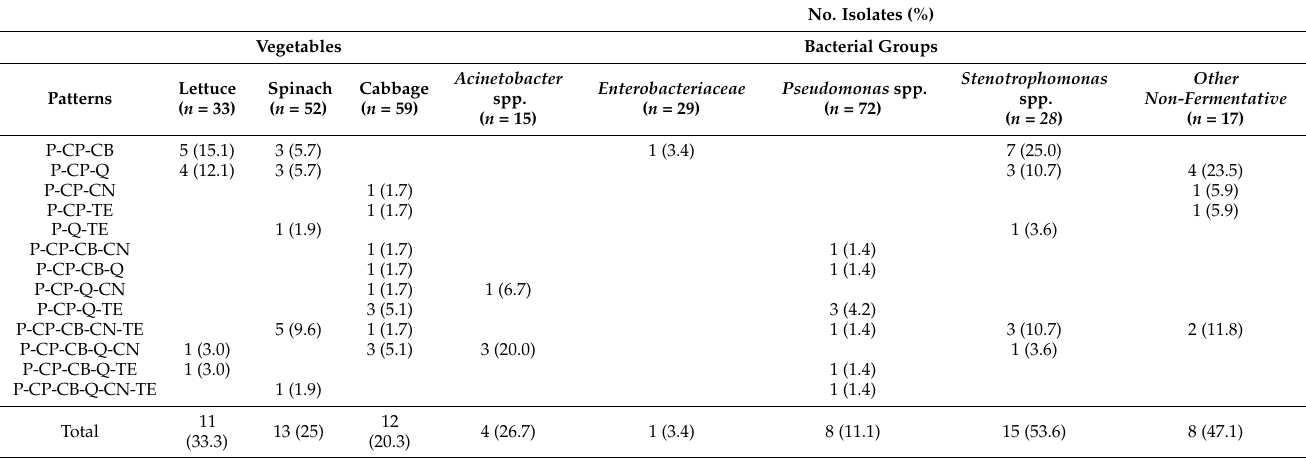
Table 3. Multidrug resistance patterns among